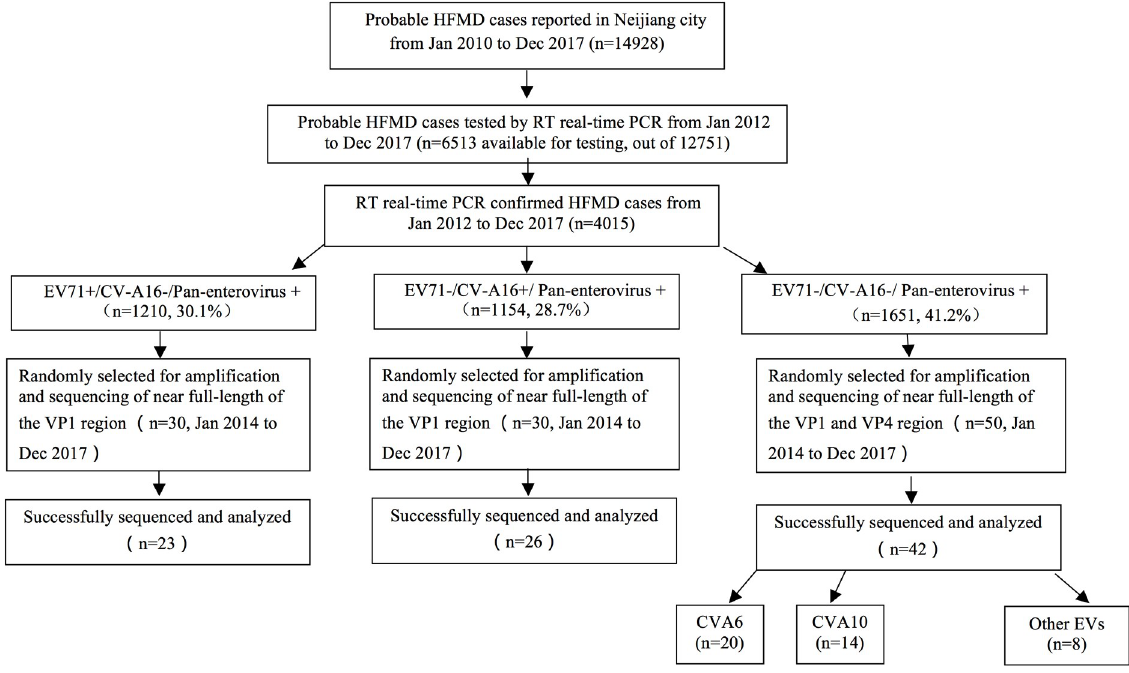
Fig 3. Flow diagram of the epidemiology and genotype investigation of HFMD patients. EV-A71 = enterovirus A71. CV-A16 = coxsackievirus A16. � Classification according to the criteria issued by National Health and Family Planning Commission of the People’s Republic of